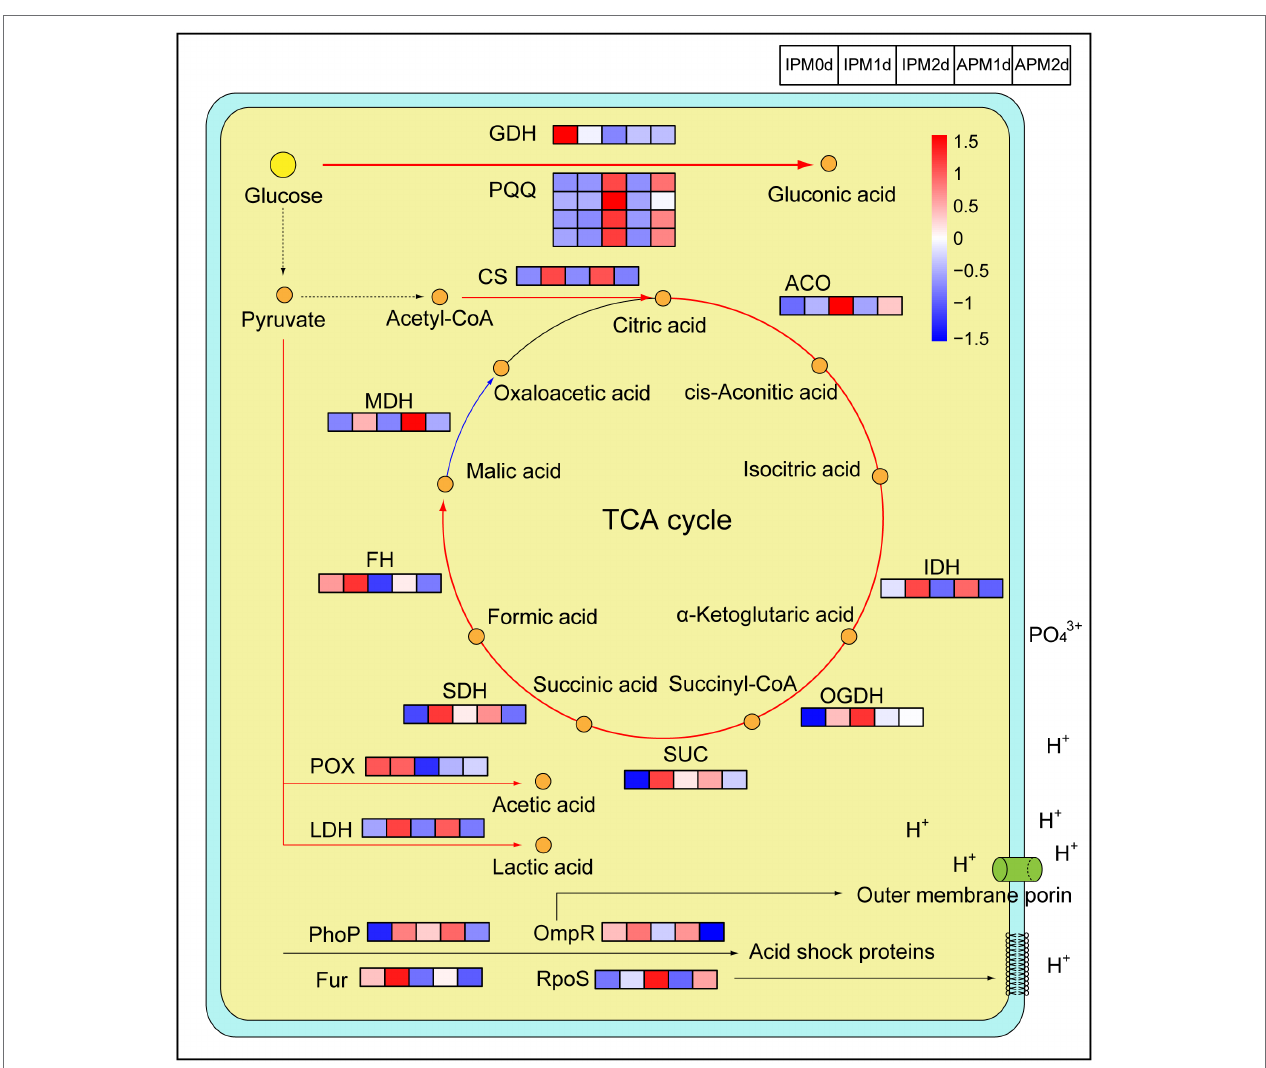
FIGURE 4 | The expression level of genes related to organic acids metabolism and acid tolerance. IPM0d, IPM1d and IPM2d represent 0 day, 1 day, and 2 days after inoculation of phosphate-solubilizing bacteria FP12 in the insoluble phosphorus medium, respectively. APM 1d and APM 2d represent 1 day and 2 days after inoculation of phosphate-solubilizing bacteria FP12 in the available phosphorus medium, respectively. Red represents high expression, and blue represents low expression. GDH, glucose dehydrogenase; PQQ, pyrroloquinoline quinone; CS, citrate synthase; ACO, aconitic hydratase; IDH, isocitrate dehydrogenase; OGDH, α -ketoglutarate dehydrogenase; SUC, succinyl-CoA synthetase; SDH, succinate dehydrogenase; FH, fumarate hydratase; MDH, malate dehydrogenase; POX, pyruvate dehydrogenase; and LDH, L-lactate